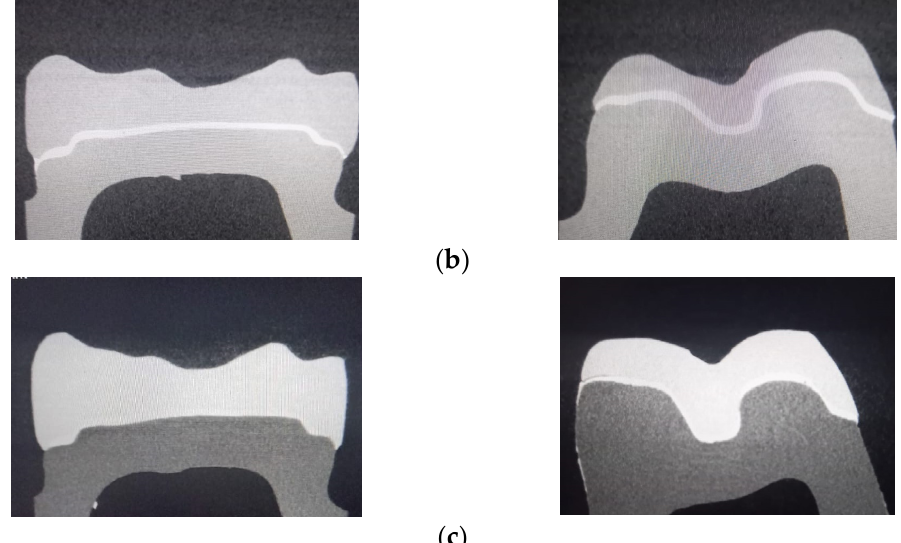
Figure 2. Micro-CT images with sagittal and coronal sections for: ( a ) Pekkton; ( b ) Juvora; ( c ) BioHPP.